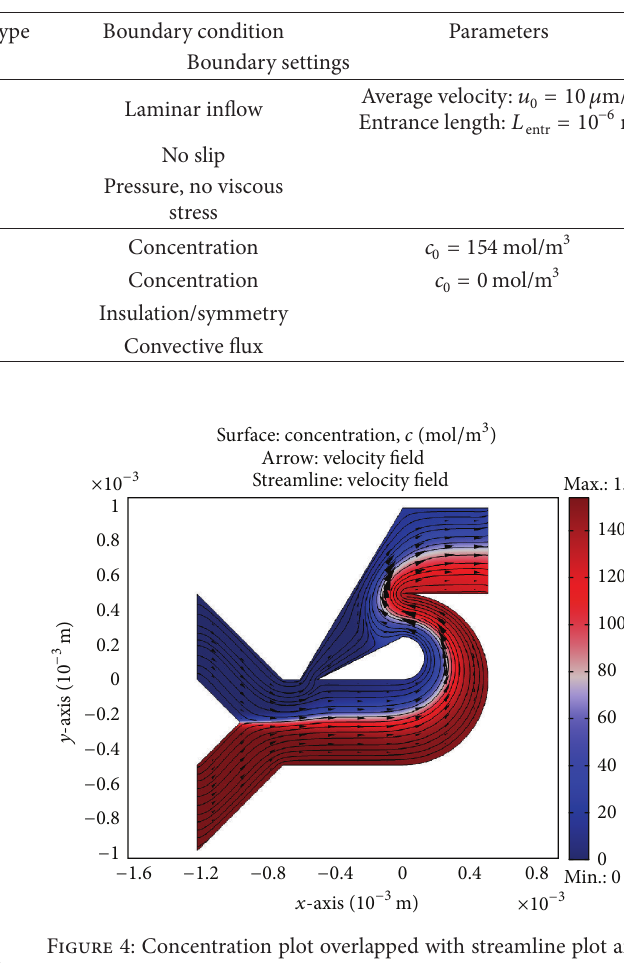
Table 1: Comsol simulation settings and input parameters used for performing the numerical simulation of the mixing process inside the micromixer with tesla elements.